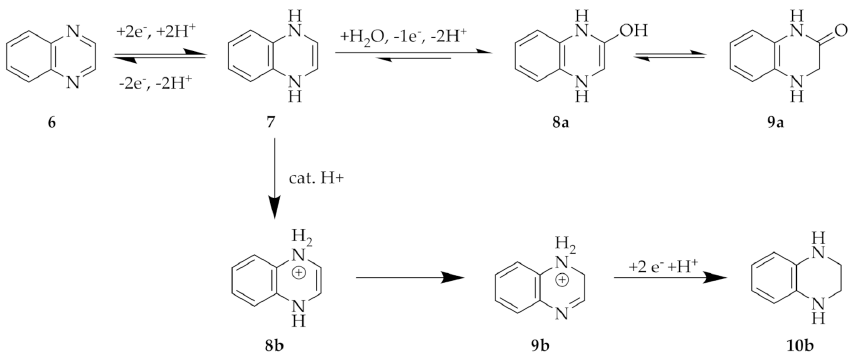
Figure 2. Degradation mechanism of quinoxaline (QUI) 6 in acidic to neutral conditions. ( a ) For- mation of quinoxalin-2-ol and/or 1,2,3,4-tetrahydroquinoxaline-2-one [15]. ( b ) Formation of 1,2,3,4- tetrahydroquinoxaline [18].